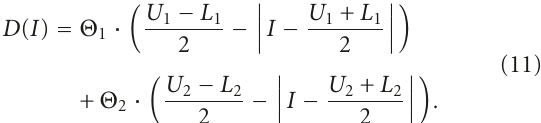
[ L 1 , U 1 ] and negative in the other intervals. The speed function F ( I ) evolutes level set function and the active contours approach the boundaries of regions whose intensity values are in between [ L 1 , U 1 ] or [ L 2 , U 2 ] ranges. An example is to segment a synthetic image as shown in Figure 4(a). There are nine numbered square regions with di ff erent gray intensities in Figure 4(b). The gray value of the first block is twenty and the other square regions have gray values increased by twenty-five. Figure 4(c) is the segmentation result obtained by threshold level set method with only one interval [ L , U ] = [35,250] containing all grey values. Because the gray values of the 2th to 9th square regions are between 35 and 250, these square regions are segmented. Figure 4(d) shows the segmentation result by setting intervals [ L 1 , U 1 ] = [35,80] and [ L 2 , U 2 ] = [200,250]. The 2th, 3th, 8th, and 9th square regions are surrounded by red lines. Figure 4(c) shows the segmentation results with only a single interval and Figure 4(d) shows the segmentation results with two